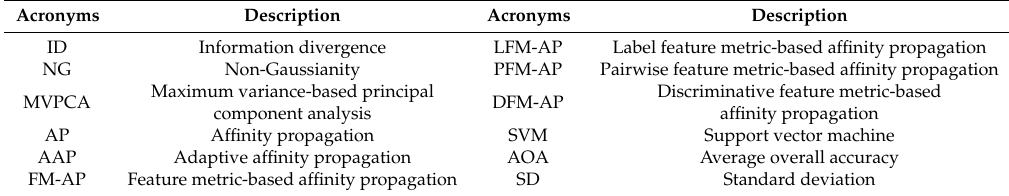
Table 1. Description of the acronyms of compared methods and evaluation criteria used in experiments.